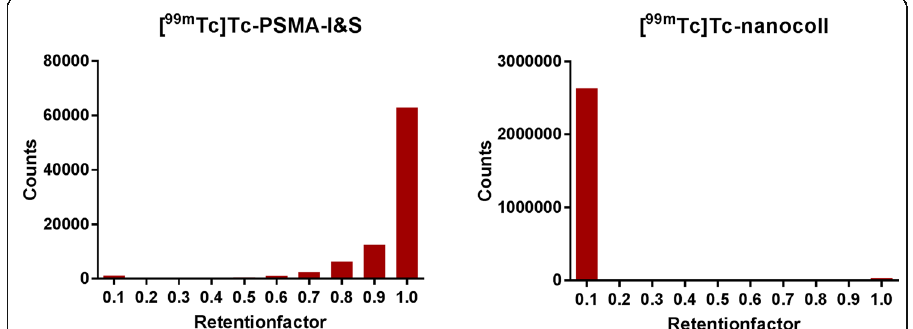
Fig. 3 Instant thin layer chromatography of both [ 99m Tc]Tc-nanocoll and [ 99m Tc]Tc-PSMA. The